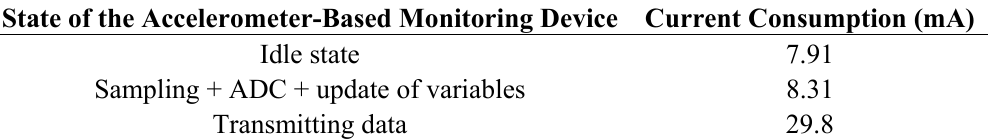
Table 4. Accelerometer current